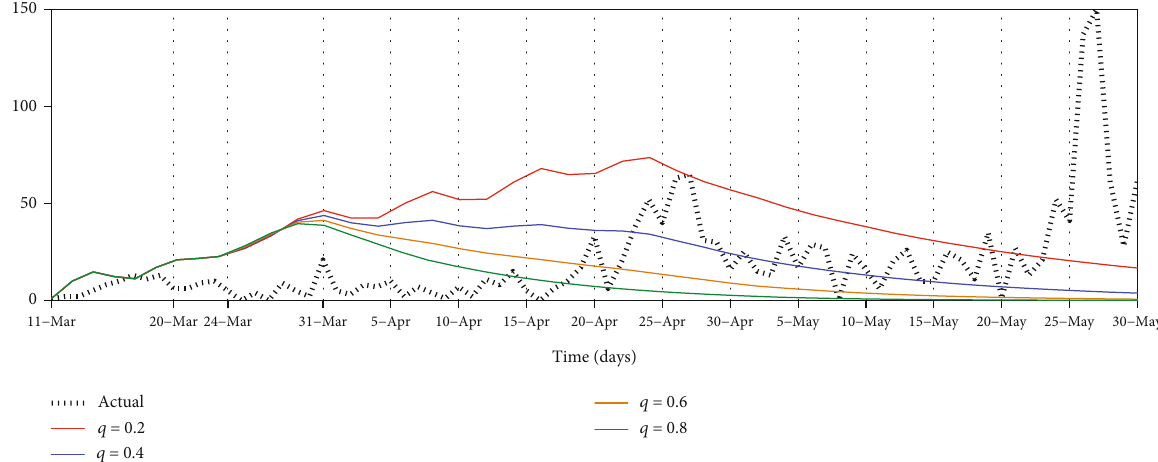
Figure 8: Comparison of actual infected data and simulation results for di ff erent quarantine values in Sri